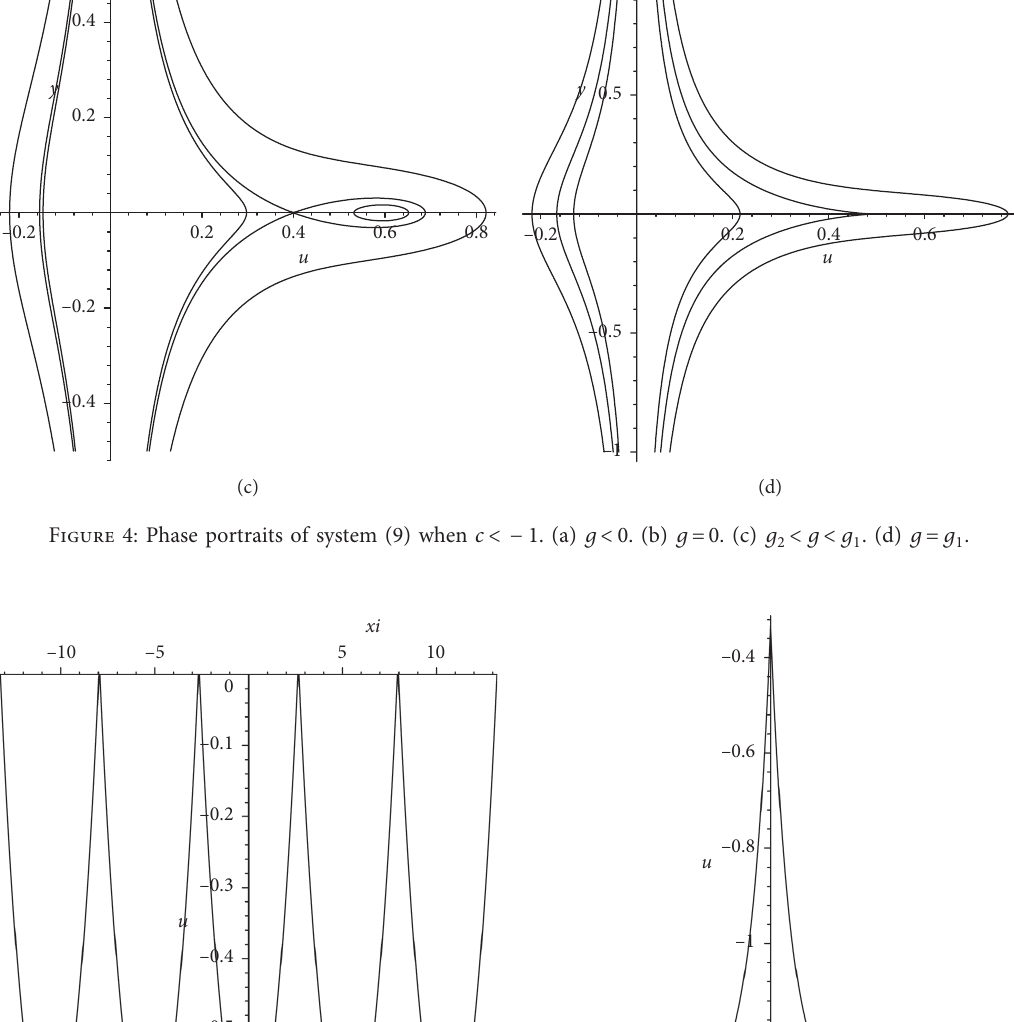
Figure 5: Profiles of periodic peakon solution and peakon solution. (a) Periodic peakon solution for c � 1 , g � 2/3, and h � 0. (b) Peakon solution for c � 1 , g � 8/9, and h �